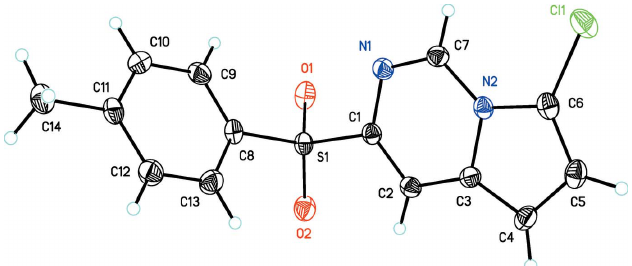
Figure 1 The molecular structure of the title compound, showing 50% probability